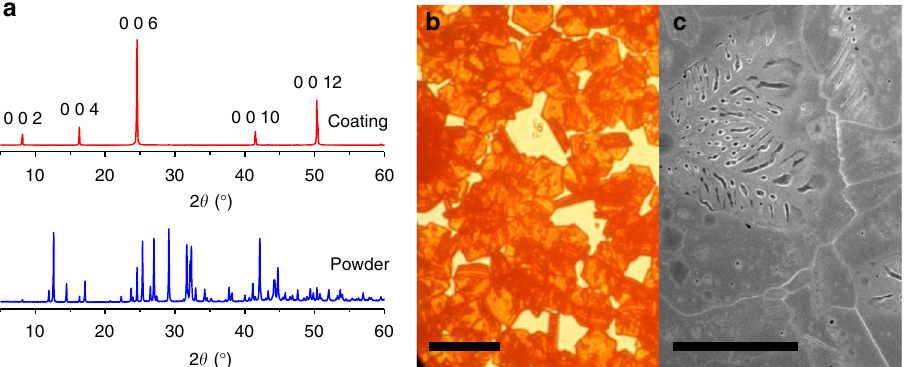
Fig. 2 Structure characterisation of the orientated (CH 3 NH 3 ) 3 Bi 2 I 9 coating on quartz. a X-ray diffraction results from the coating and powdered samples. b Optical microscope and c scanning electron micrograph of the (CH 3 NH 3 ) 3 Bi 2 I 9 coating processed by depositing and drying of the solution of BiI 3 and CH 3 NH 3 I in N,N-Dimethylmethanamide. The scale bars represent 25 μ m